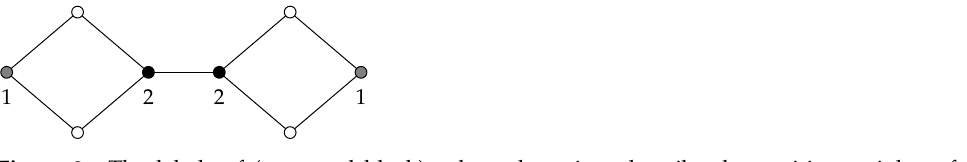
Figure 2. The labels of (gray and black) coloured vertices describe the positive weights of a γ qtR ( G ) -function.